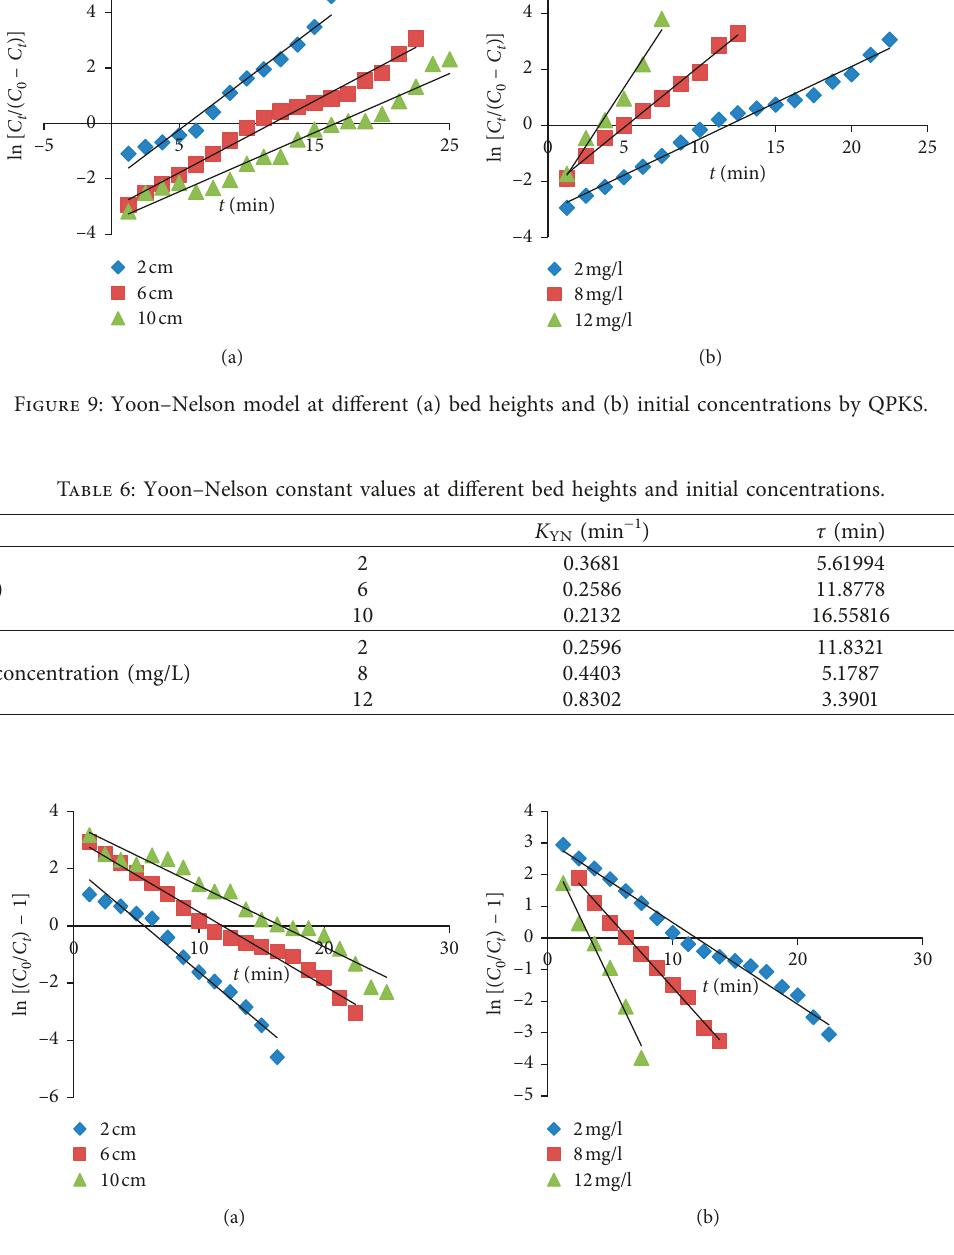
Figure 10: Plot of Thomas model at different (a) bed heights and (b) initial concentrations. Table 7: Constant values of Thomas model at different bed heights and initial concentrations by